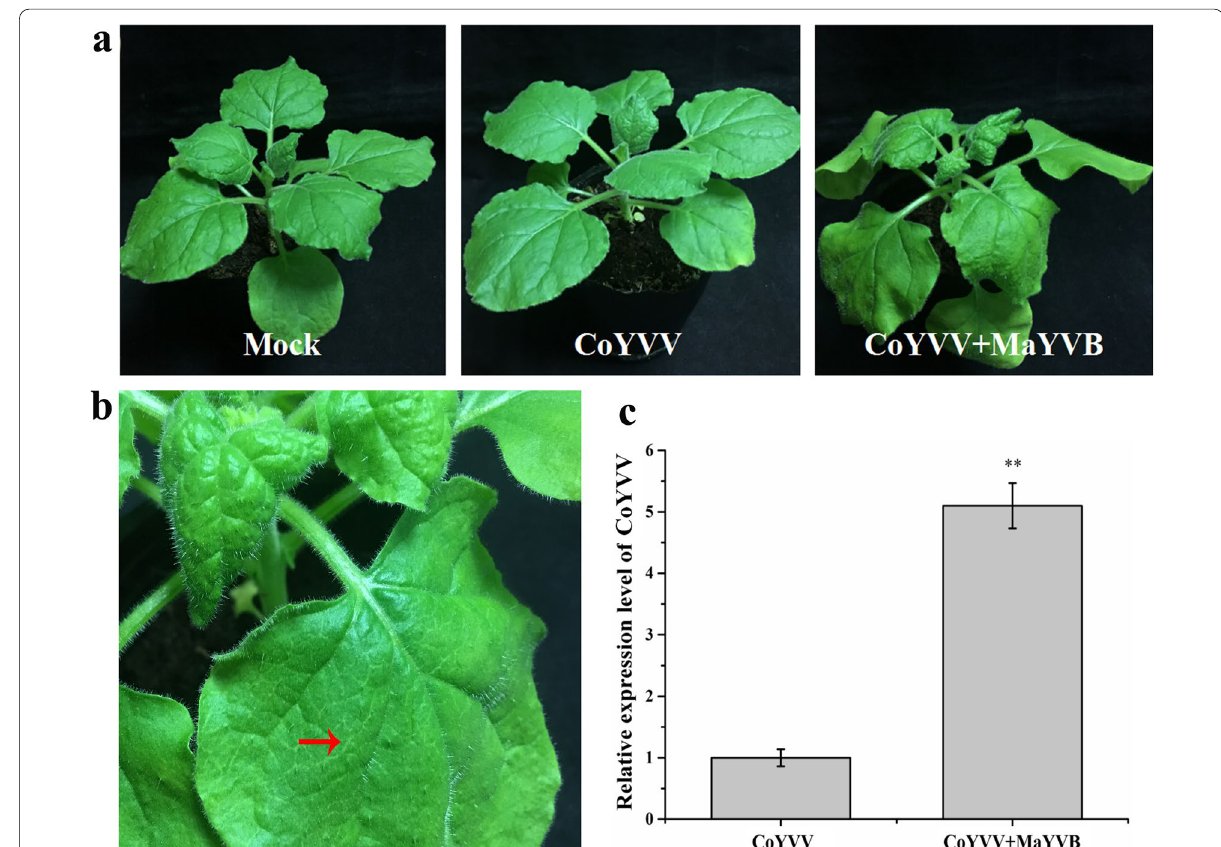
Fig. 3 Symptoms induced by CoYVV infection or CoYVV and MaYVB co-infection in N. benthamiana . a Symptoms induced by CoYVV infection or by CoYVV and MaYVB co-infection in N. benthamiana . b A close up image showing the yellow vein (red arrow) and downward-leaf rolling symptoms caused by CoYVV and MaYVB co-infection. The plants were photographed at 14 dpi. c qPCR analysis of CoYVV accumulation in N. benthamiana plants infected with CoYVV or co-infected with CoYVV and MaYVB. ** indicates a significant difference ( P < 0.01) between the